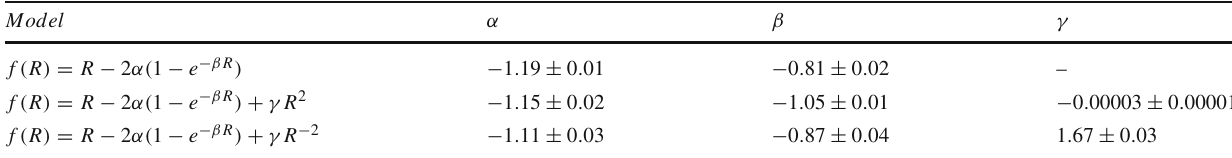
Fig. 2 The GP reconstruction of | V (cid:3) | / V , Eq. (19), for the 30 H ( z ) samples deduced from the differential age method with 10 additional samples obtained from the radial BAO method (Table 1) is depicted on the left hand side plot, when H 0 = 73 . 52 ± 1 . 62 km s − 1 Mpc − 1 has been merged to the expansion rate data used in the GP. The right hand side plot represents the GP reconstruction of | V (cid:3) | / V , Eq. (19), when